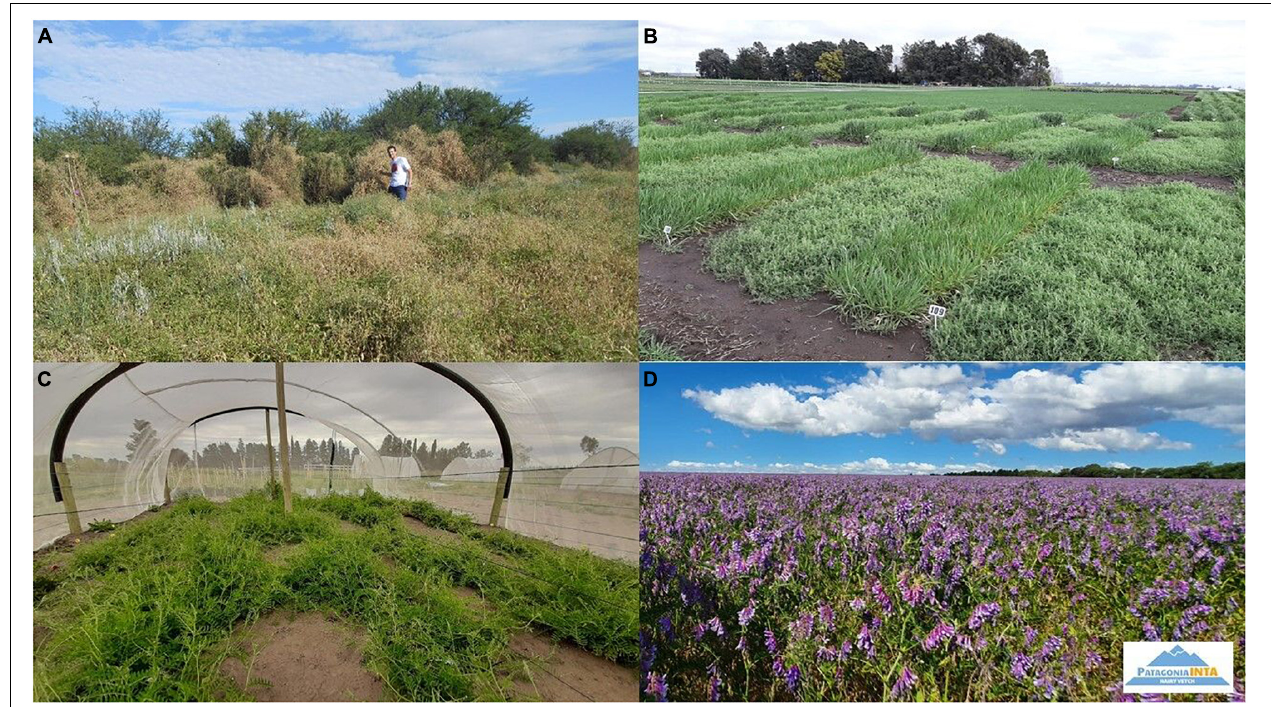
FIGURE 2 | Seed collection (A) , plant breeding (B) , multiplication (C) , and agronomic use (D) of the improved cultivar of hairy vetch ( Vicia villosa ) cv. Patagonia INTA as forage and cover